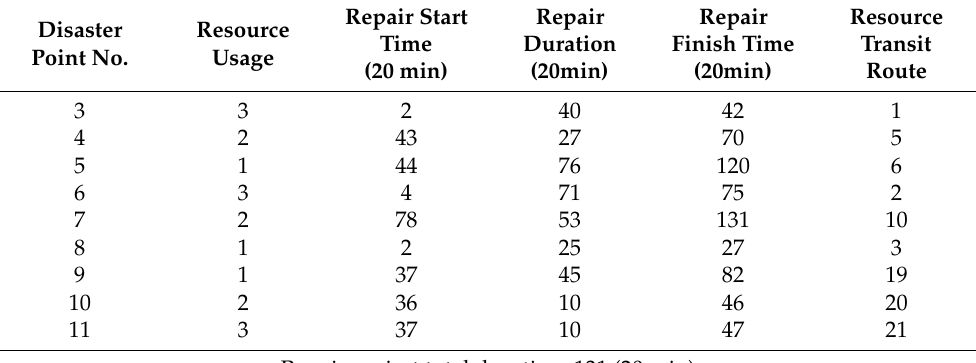
Table 13. Rescheduling results after new resource point is added (Case